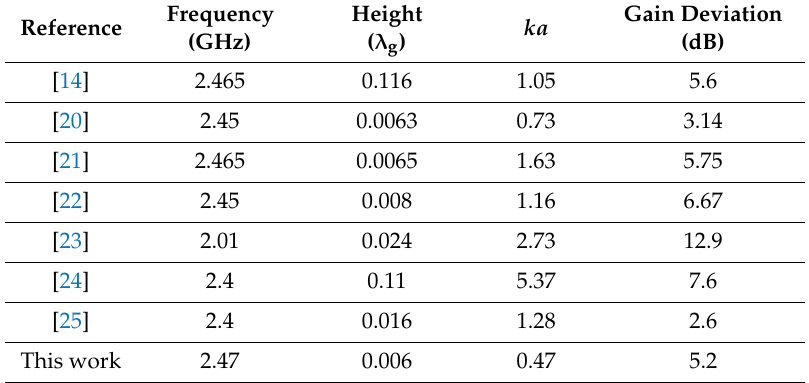
Table 3. Antenna performance comparison of proposed design with the previously published design.